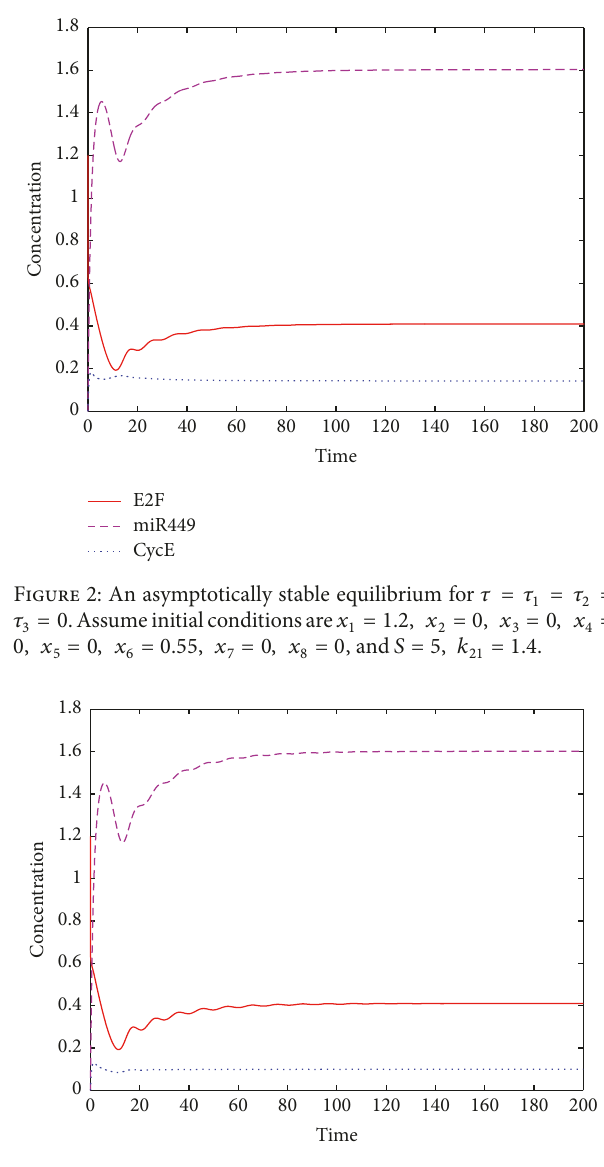
Figure 3: An asymptotically stable equilibrium for 𝜏 = 𝜏 1 = 𝜏 2 = 𝜏 < 𝜏 3 0 . Assume initial conditions are 0, 𝑥 = 0, 𝑥 = 0, 𝑥 = 0.55, 𝑥 4 5 6